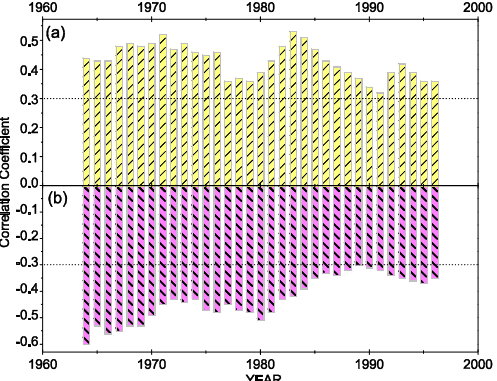
Figure 5. Variation of 31 year sliding correlation coefficient be- tween (a) TI 1 and ISMR and (b) TI 2 and ISMR for the study period. Horizontal dotted line denotes the line 5% level significance.